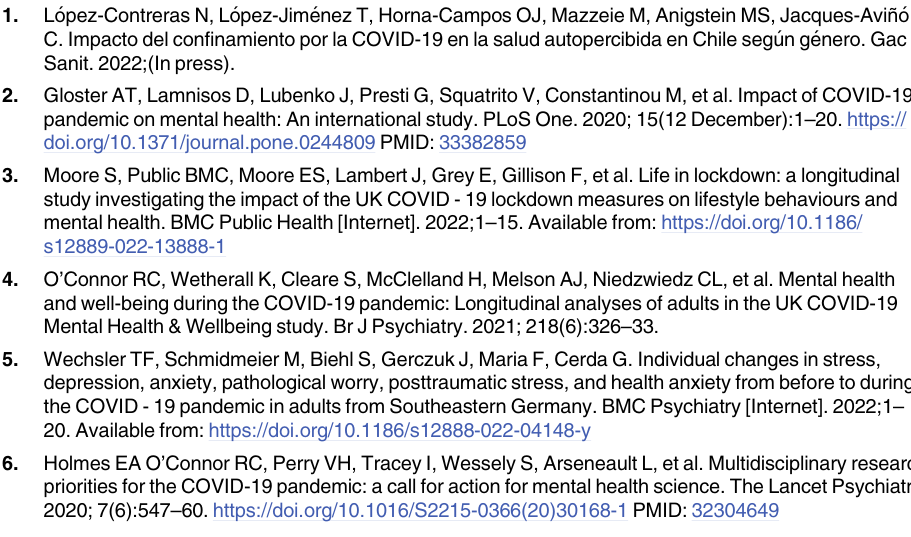
S2 Table. Adjusted odds ratios of regular or bad health self-perception excluding: (i) high and low educated subjects, (ii) those with chronic diseases, (iii) those with severe anxiety, and (iv) those with severe depression. S3 Table. Adjusted odds ratios of regular or bad health self-perception stratified by sex according to the parsimonious logistic regression model of Table 3 of the main